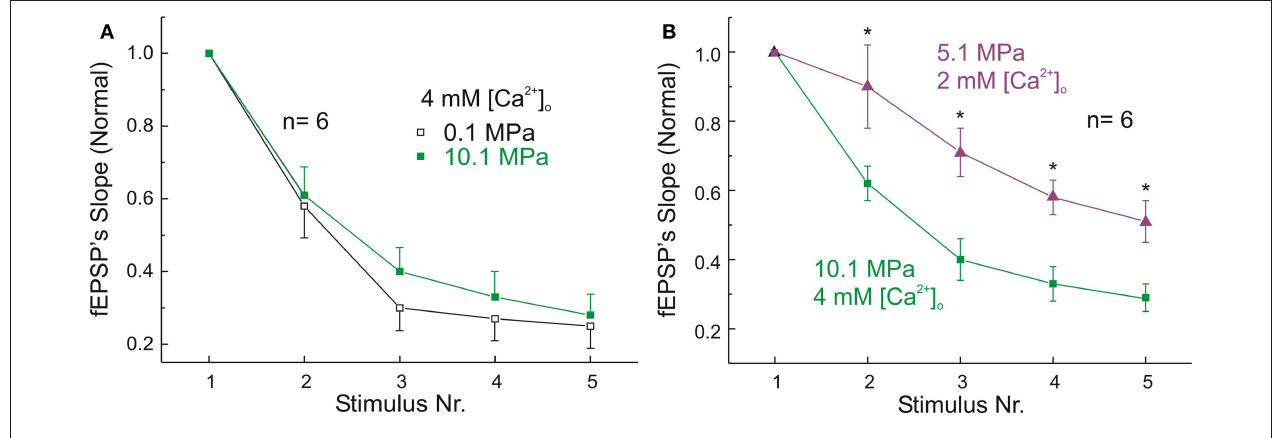
Figure 5 | effect of pressure on the dynamics of MPP’s FDD. (A) Similar FDD is induced by 4 mM [Ca 2 + ] were normalized with respect to their corresponding E condition; differences at each stimulus were not statistically significant).